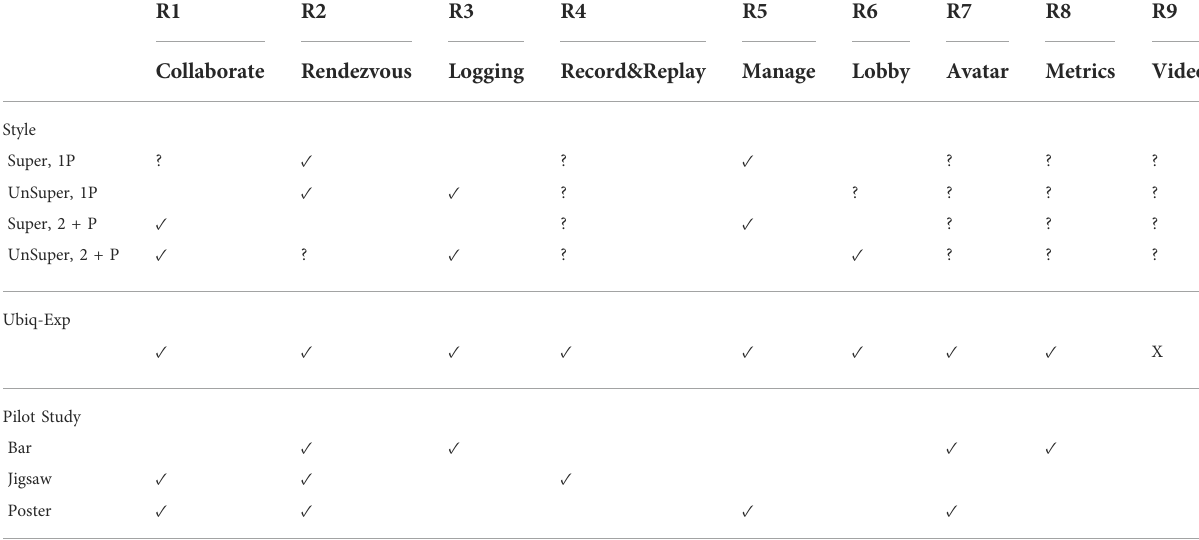
TABLE 2 Requirements for the four styles of experiment identi fi ed and the three pilot